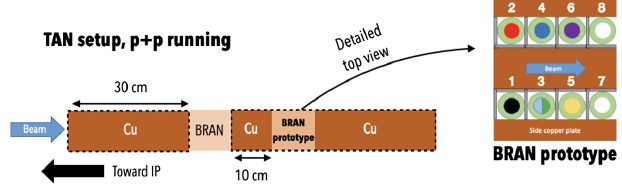
FIG. 1. TAN setup during LHC Run 2 p þ p running (2016 – 2018). The dashed lines identify the slot used to install the zero degree calorimeter during the Heavy Ion runs. The right inset shows a top view of the BRAN prototype. The numbers identify the position of the fused silica rods. Detailed information on the materials of the rods and maximum irradiation reached for each of them are reported in Table I.